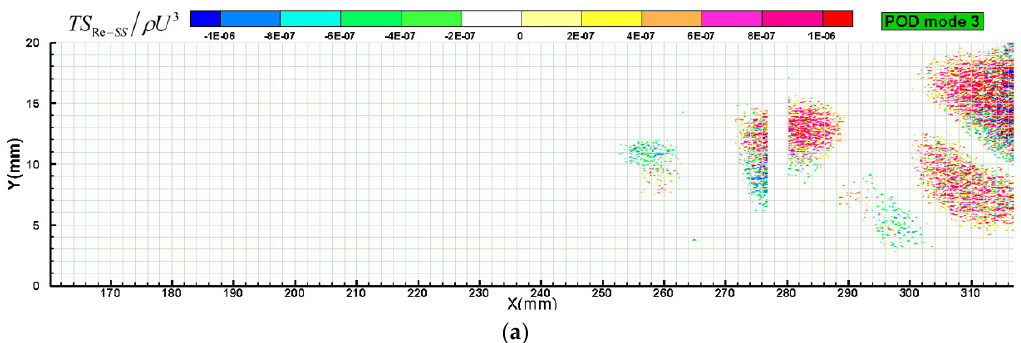
Figure 15. Entropy generation of second order mode: ( a ) the Reynolds sheer stress term; ( b ) the Reynolds normal stress term; and ( c ) the energy flux term.